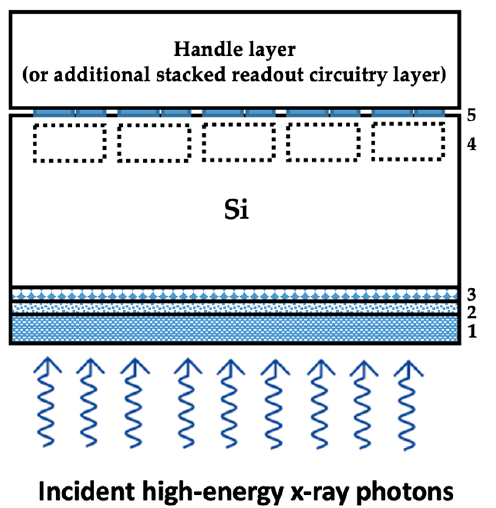
Figure 2. A schematic of the cross-section of the PAL-Si detector system. Region 1 is the PAL, 2 is a backside passivation oxide layer, 3 is either implants or epitaxial growth for surface pinning, region 4 is the pixelated carrier storage wells, and 5 is front side pixel readout circuitry or hybrid bonds to 3D stacked readout circuitry.